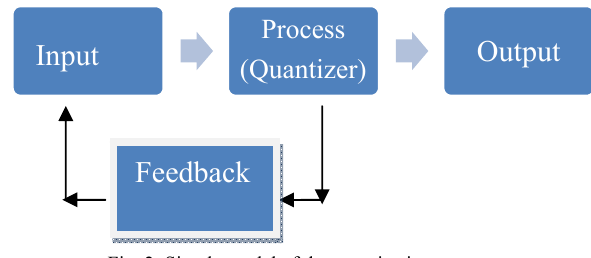
Fig. 2: Simple model of the quantization